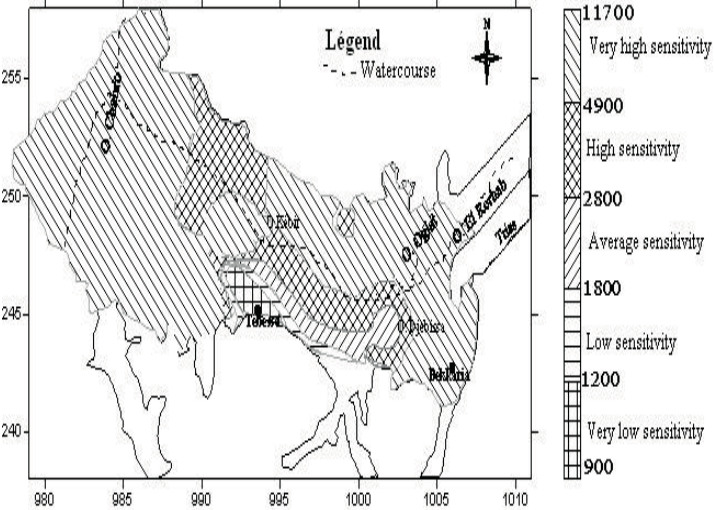
Fig. 5 Map of the sensitivity indexing of irrigation water to the Tebessa Plain.